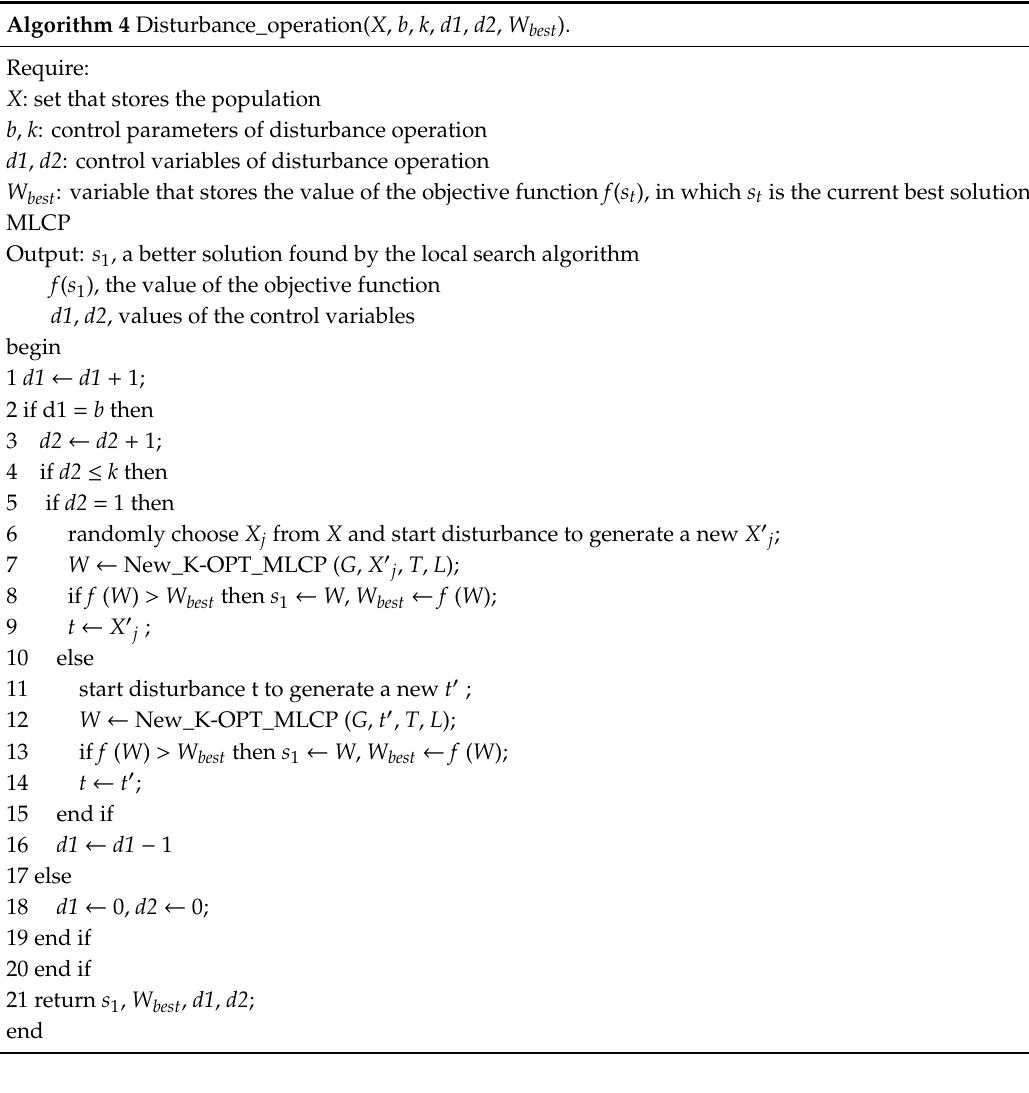
Algorithm 4 Disturbance_operation( X , b , k , d1 , d2 , W best